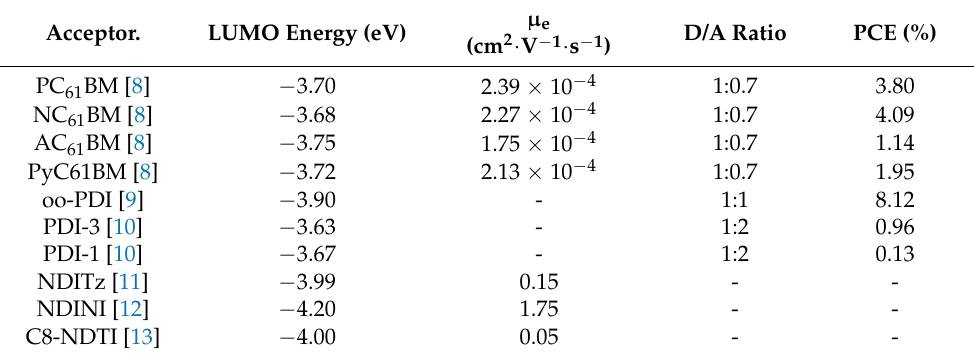
Table 1. LUMO energy levels (obtained by electrochemical measurements), electron mobility values, donor/acceptor ratio and power conversion efficiency (PCE%) of fullerene derivatives and some organic small molecules used as n-type semiconductors. Acceptor. LUMO Energy